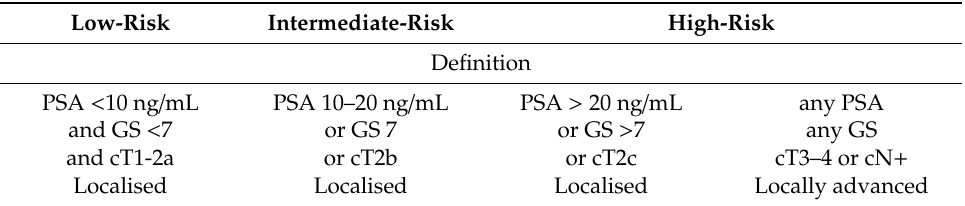
Table 5. Risk groups for biochemical recurrence of localised and locally advanced prostate cancer, as introduced in the joint guidelines of the European Association of Urology, the European Society for Radiotherapy & Oncology and the International Society of Geriatric Oncology 2016